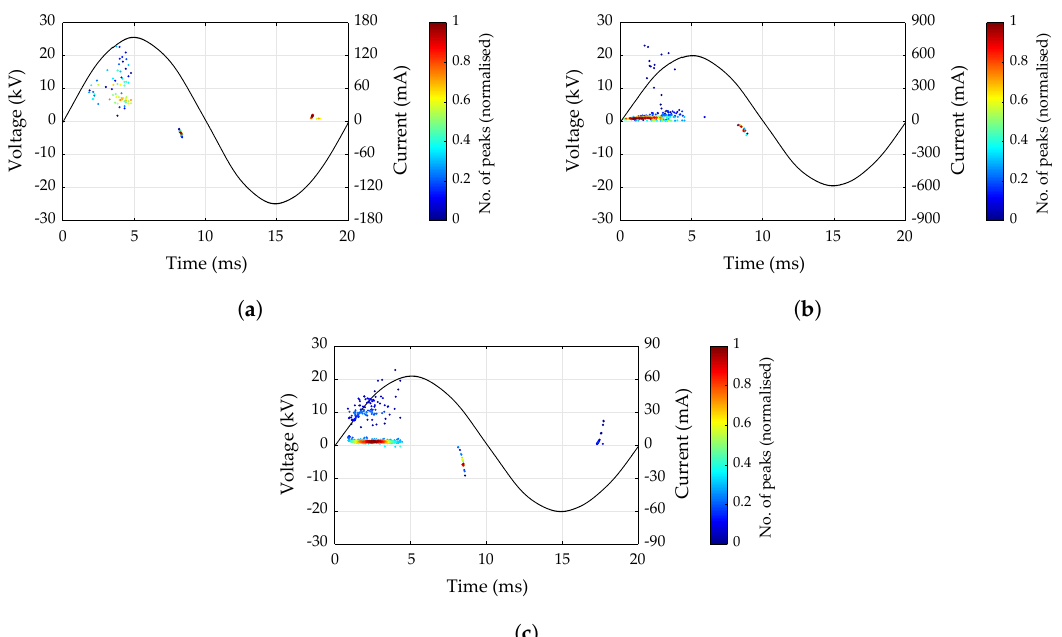
Figure 13. Current peaks densities for 4mm thickness insulator samples in nitrogen (N 2 ) at 1bar absolute pressure: ( a ) PTFE, ( b ) epoxy resin and ( c ) silicone rubber.